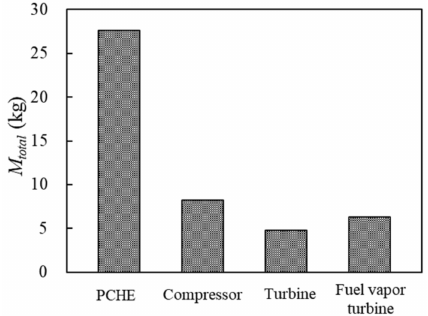
Figure 14. The fuel weight penalty of each component.